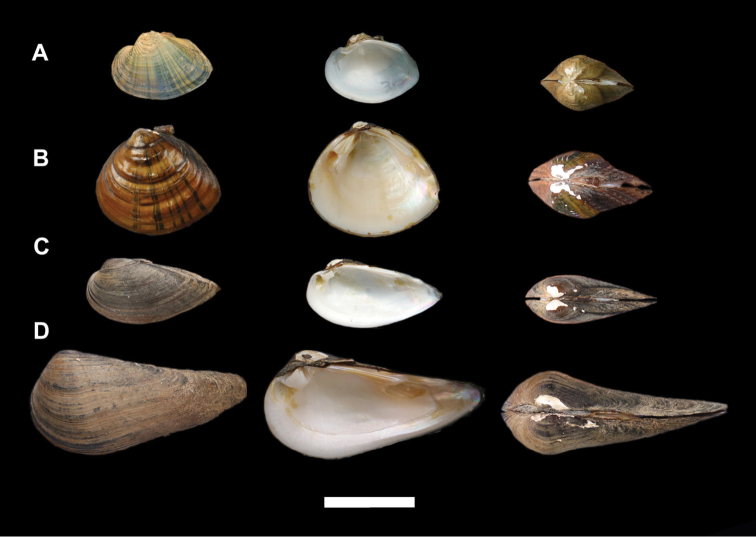
Shells of the unionids species in this study. AAcuticostachinensis (Lea, 1868) BSchistodesmuslampreyanus (Baird & Adams, 1867) CCuneopsisheudei (Heude, 1874) DCuneopsiscapitatus (Heude, 1874). Scale bar: 4 cm. Photogaphs R-W Wu.